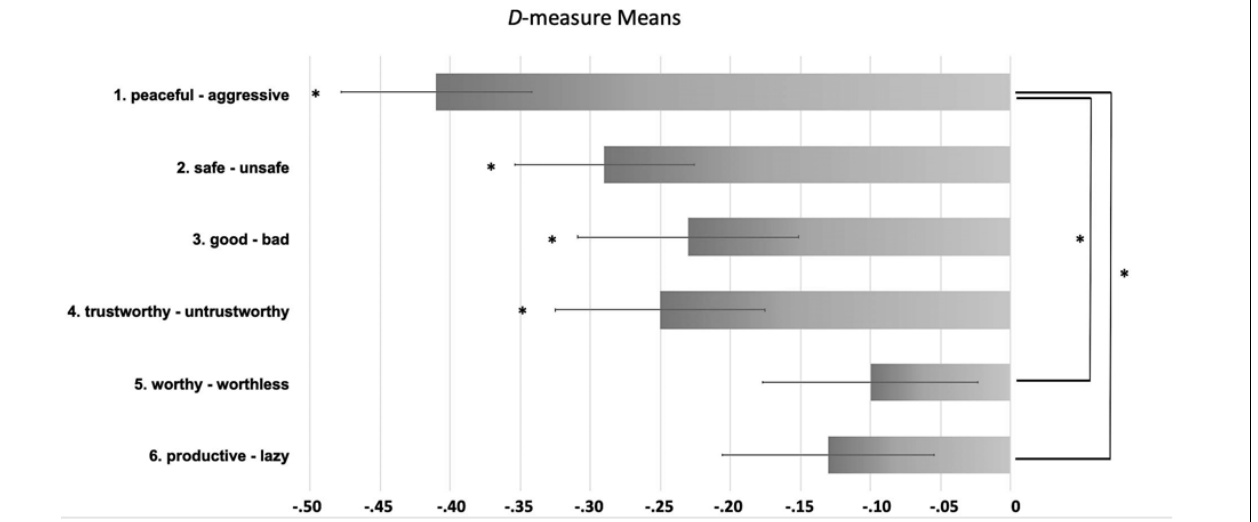
FIGURE 2 | Comparison of mean D -measures of the six attribute dimensions. Means are displayed with ± 1 standard error of the mean (SEM). Negative D -measure scores indicate a faster response ratio to the negative dimension concept and PaCA and the positive dimension concept and Non-PaCA, respectively. D -measures significantly differing from zero (Tukey-Test) are marked ∗ p <